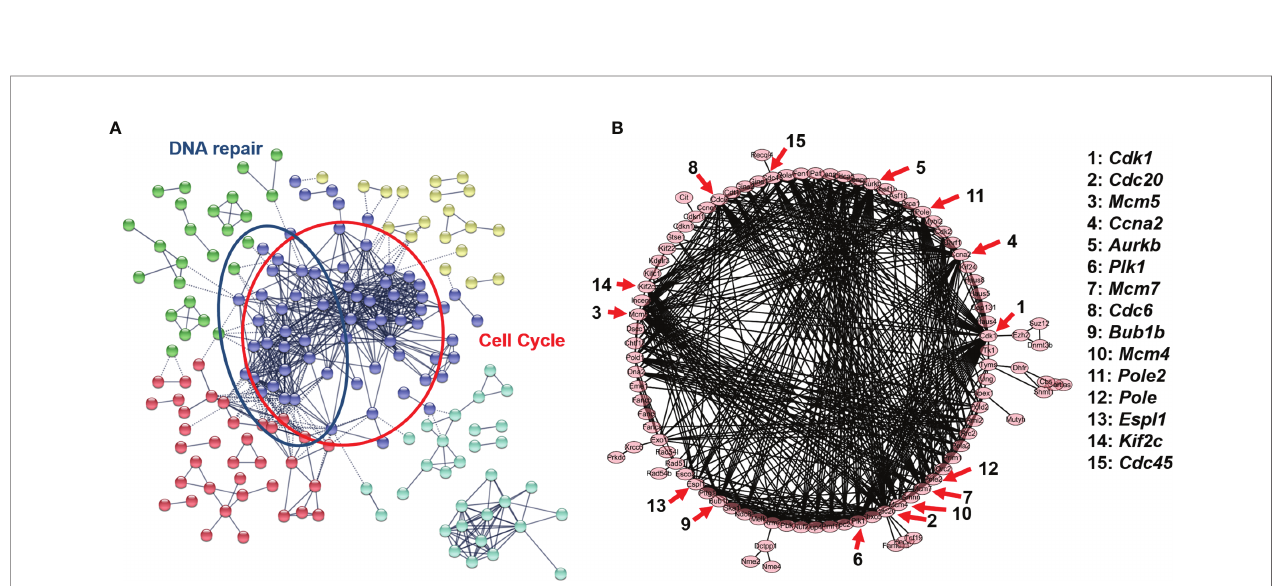
FIGURE 3 | (A) Protein-protein interaction network of B.END3 cells with PDT intervention (p-adj<0.05 and |log 2 FoldChange|>1.0). (B) Sub-network of cell cycle- related genes and 15-top